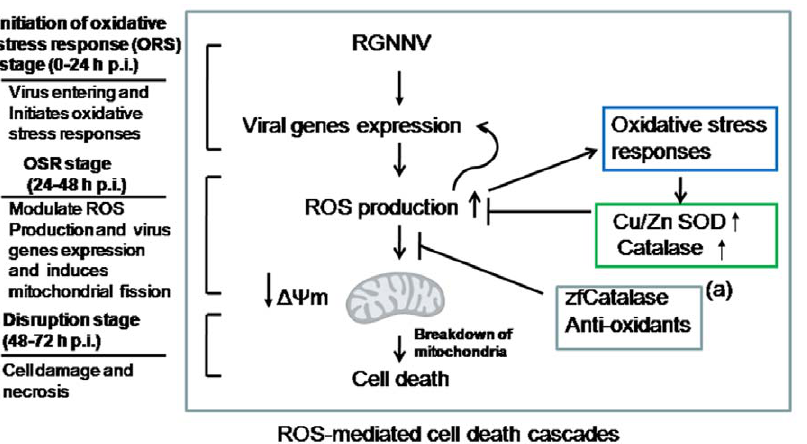
Figure 7. A schematic illustrating our hypothesis of RGNNV infection induced ROS-mediated cell death. RGNNV first can enter and express viral early gene at early replication stage [0–24 h pi; initiation of oxidative stress response (OSR) stage], then induces ROS production apparently in mitochondria and initiates oxidative stress responses. Furthermore, at middle replication stage (24–48 h pi; OSR stage), oxidative stress responses are dramatically (1) up-regulating the antioxidants enzymes Cu/Zn SOD and catalase, (2) affecting the viral replication for mild increasing virus titer and (3) eventually producing mitochondrial breakdown as a fission action. Finally, cells undergo a ROS-mitochondria-mediated cell death at late replication stage (at 48 h-72 h pi; disruption stage). RGNNV-induced death signaling is halted by anti-oxidants DPI and NAC or anti-oxidant enzyme zfCatalase over-expression (a) for reducing ROS production and enhancing cell viability. Fig. 6B: a–d [RGNNV-infected cells, no treatment]) but reducing mitochondrial fragmentation in length (Fig. 6B: m–p) that especially in enlarged image Fig. 6B:r as compared with no NAC treatment Fig. 6B:q at 48 h pi. These results suggest the involvement of ROS production as well as other factors in the induction of mitochondrial fragmentation. Finally, NAC and DPI (Fig. 6C) also can blocked RGNNV-induced MMP loss up to 30% (48 h pi) and 60% (72 h pi; late replication stage) during replication, which support RGNNV induction of ROS affect GF-1 viability.